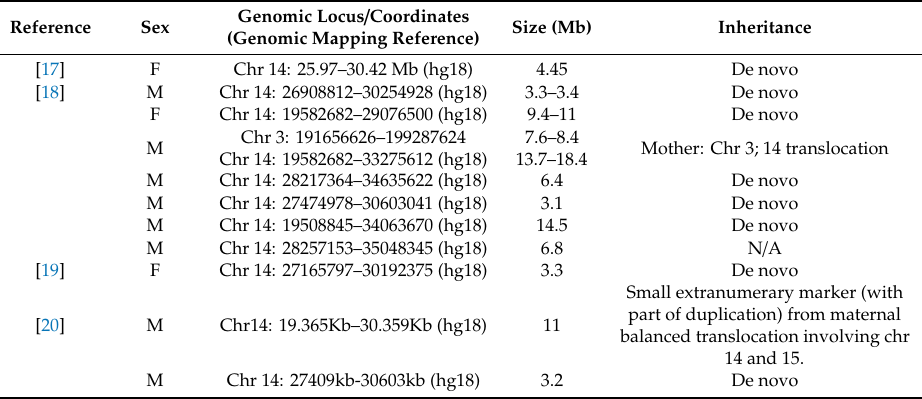
Table 2. The published cases of 14q duplication encompassing FOXG1